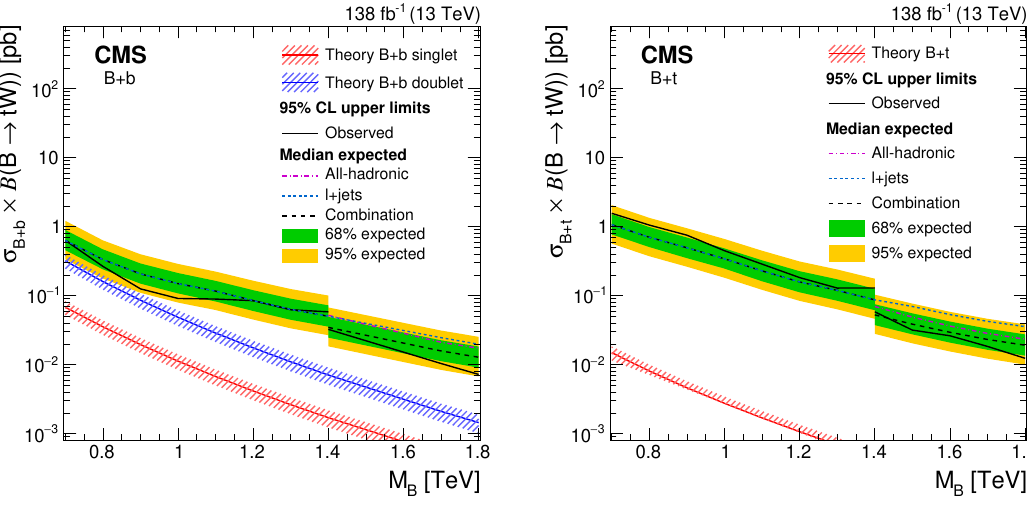
Figure 4 . Upper limits on the product of production cross section and branching fraction of the B + b (left) and B + t (right) production modes at 95% CL. Colored lines show the expected limits from the ‘ +jets (dotted) and all-hadronic (dash-dotted) channels, where the latter start at B masses of 1.4 TeV. The observed and expected limits from the combination are shown as solid and dashed black lines, respectively. The green and yellow bands show the 68 and 95% confidence intervals on the combined expected limits. The theoretical cross sections are shown as the red and blue lines, where the uncertainties due to missing higher orders are depicted by shaded